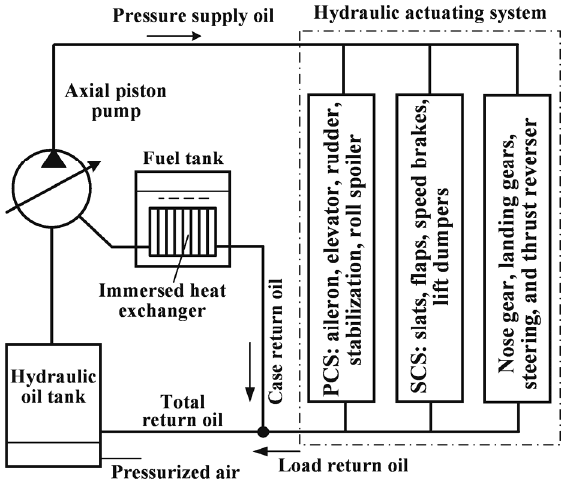
Figure 2. Modeling scheme of hydraulic system.